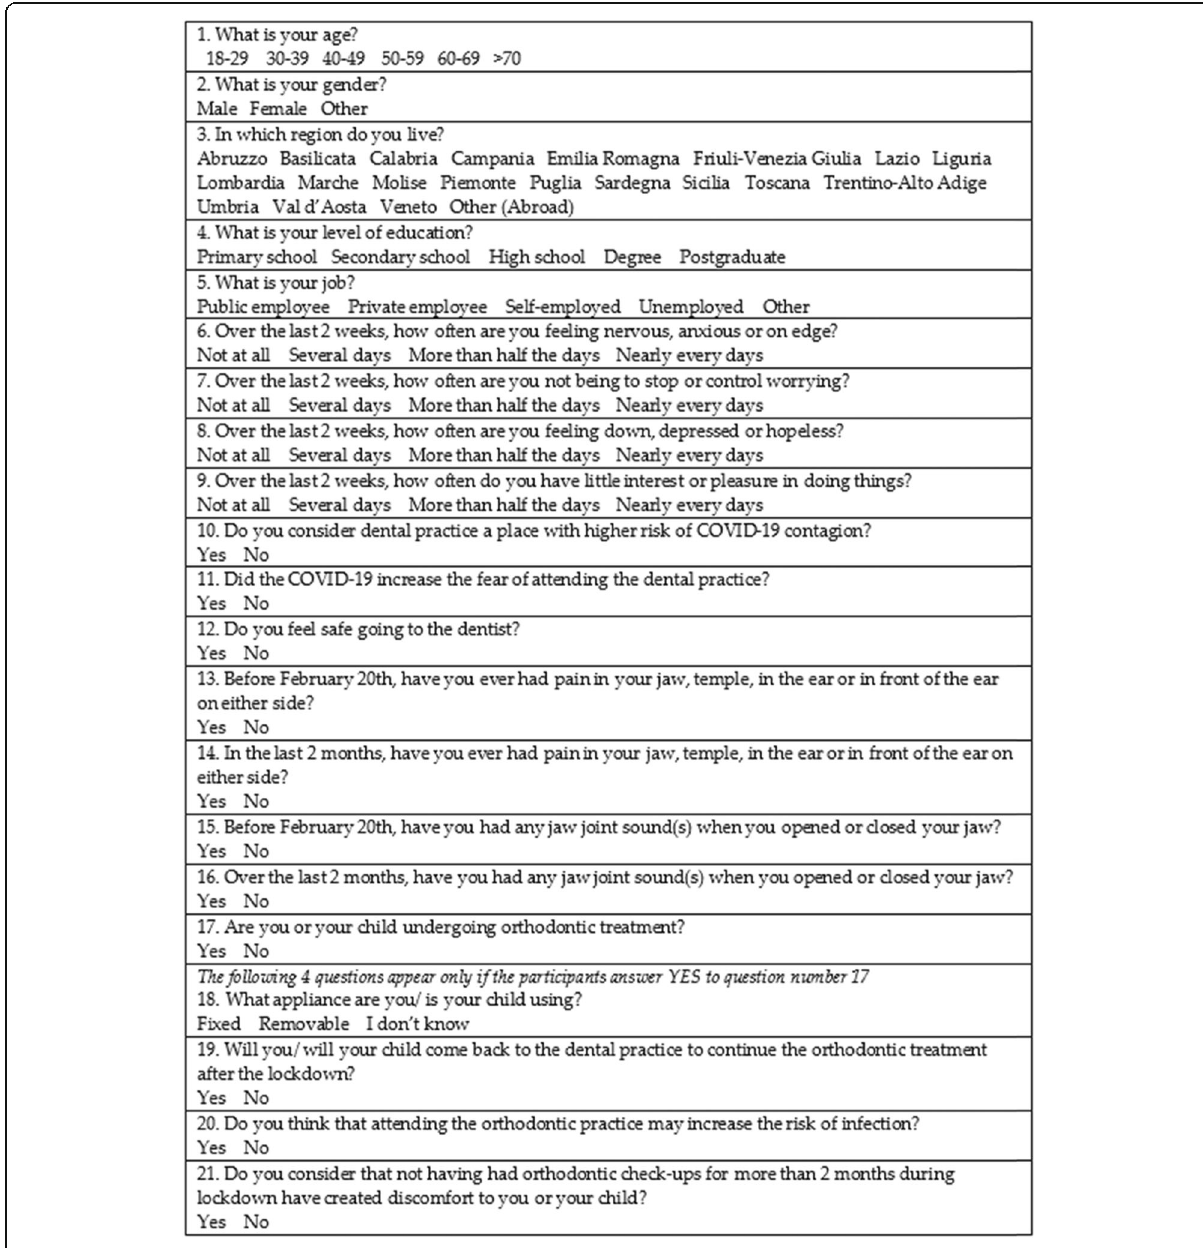
Fig. 1 Online survey questionnaire (translated in